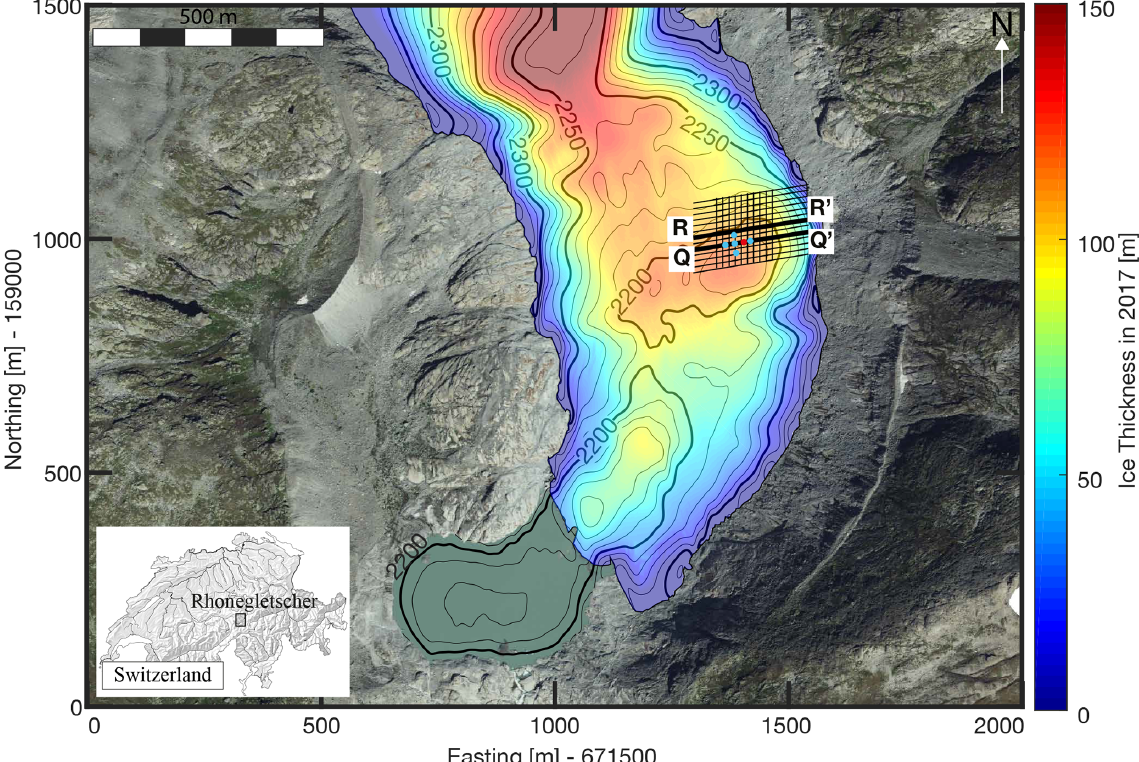
Figure 1. Map of the Rhonegletscher’s lower ablation area, ice thickness (colour-coding), basal topography (black contour lines) updated from Church et al. (2018), and GPR repeated survey site (black grid). The two thicker GPR profile lines (R-R (cid:48) and Q-Q (cid:48) ) are displayed in Figs. 3 and 4. Five boreholes were drilled in August 2018 to provide ground truths on the conduit and are marked as blue and red dots. The red dot represents the borehole where the borehole camera acquired a